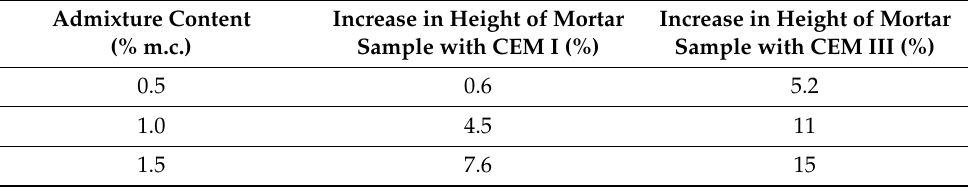
Table 2. Increase in mortar sample height in relation to reference bars depending on the amount of gas-liberating admixture.